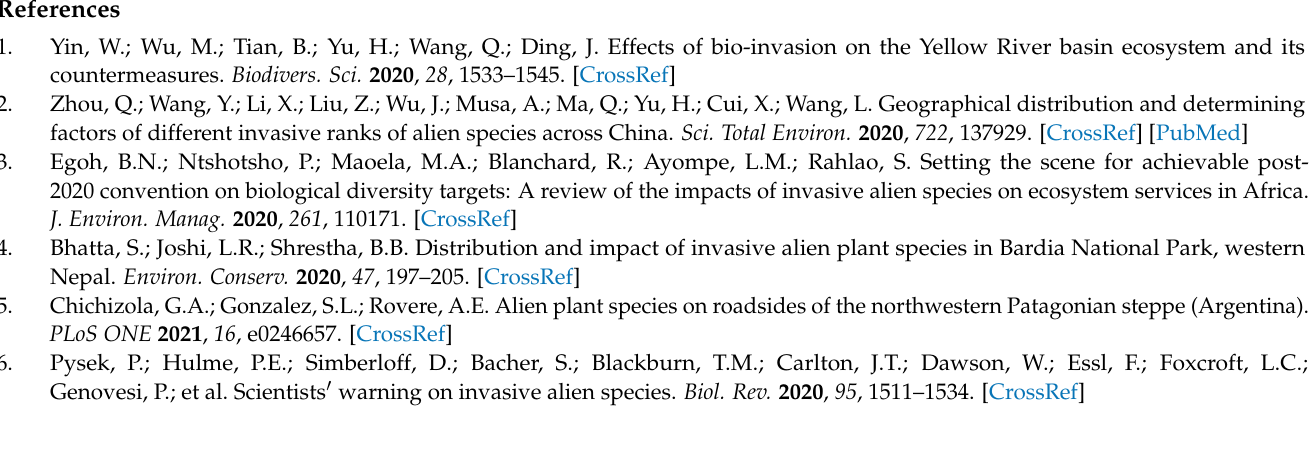
trix of the judgment, Table S2. The importance of scale, Table S3. The mean random consistency index. File S2: Corresponding table of map serial numbers and township locations, Table S4. Corresponding table of map serial numbers and township